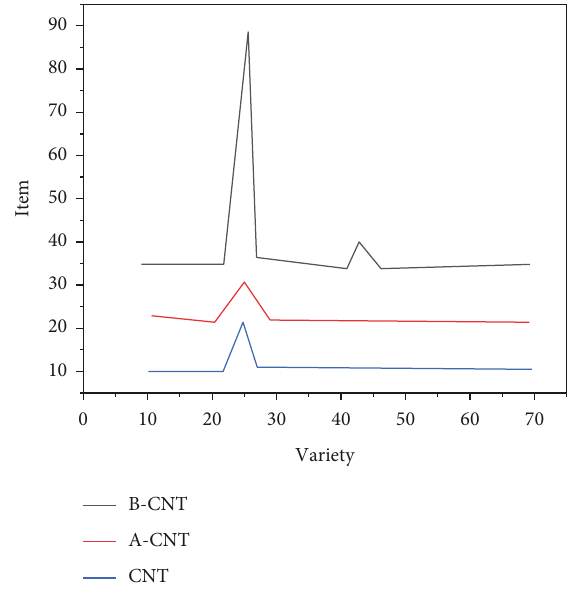
Figure 2: XRD patterns of CNT, A-CNT, and B-CNT.